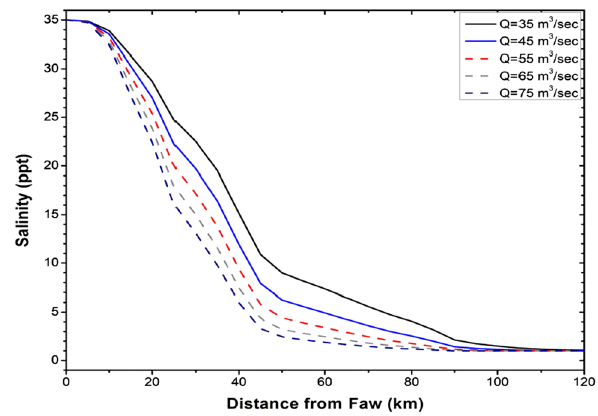
Fig. 6 Salinity intrusion limit when Karun river inflow 0 m 3 /s and different flow rates from Tigris river